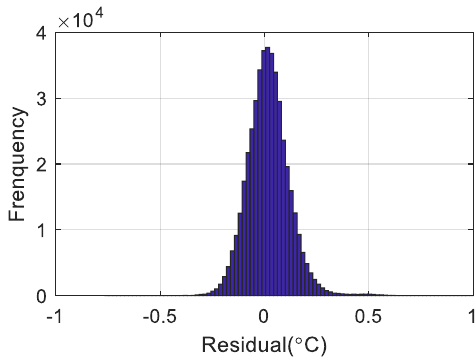
Figure 17. Residual distribution in validation set.